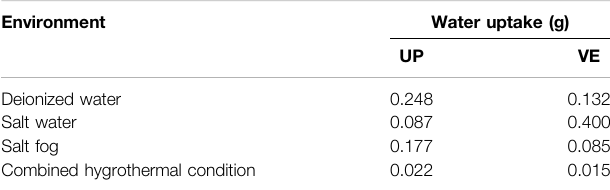
TABLE 1 | Water fi nal intake during the experimental program.